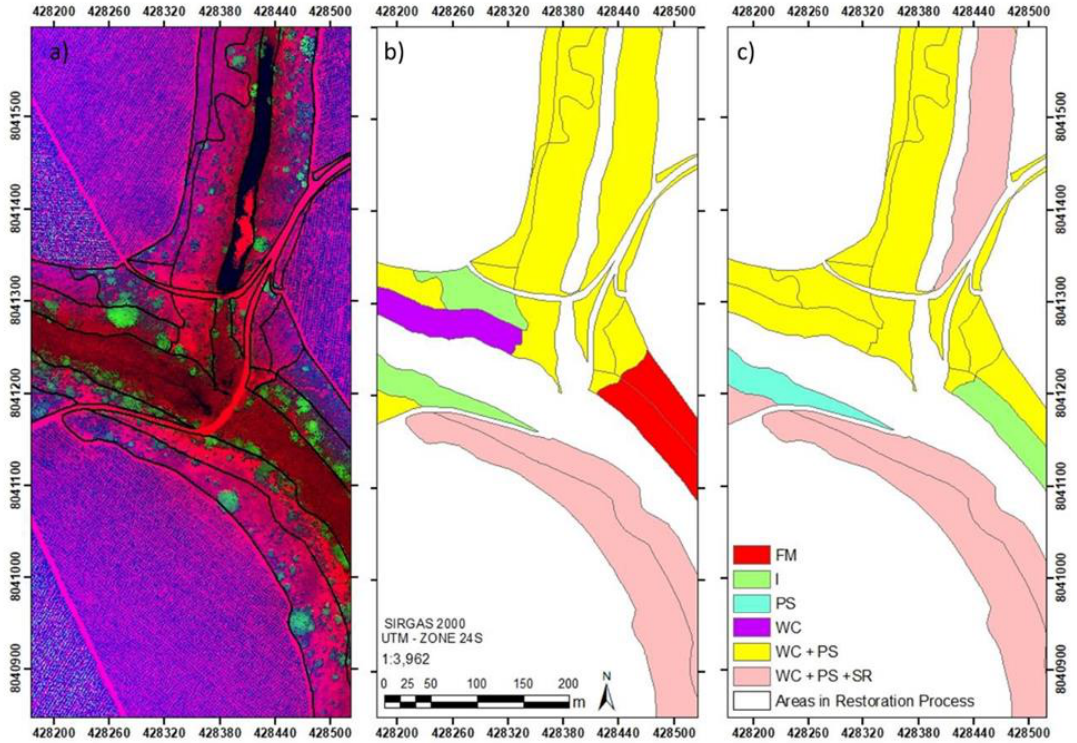
Figure 5. ( a ) LiDAR data composition images (intensity, nDSM, DSM, DTM); ( b ) management recommendations generated by LiDAR image classified with maximum likelihood algorithm; ( c ) management recommendations generated by LiDAR image classified with random forest algorithm. FM: Field monitoring, I: Isolation, WC + PS: Weed control + plant seedling, WC + PS + SR: Weed control + plant seedling + bare soil recovery.